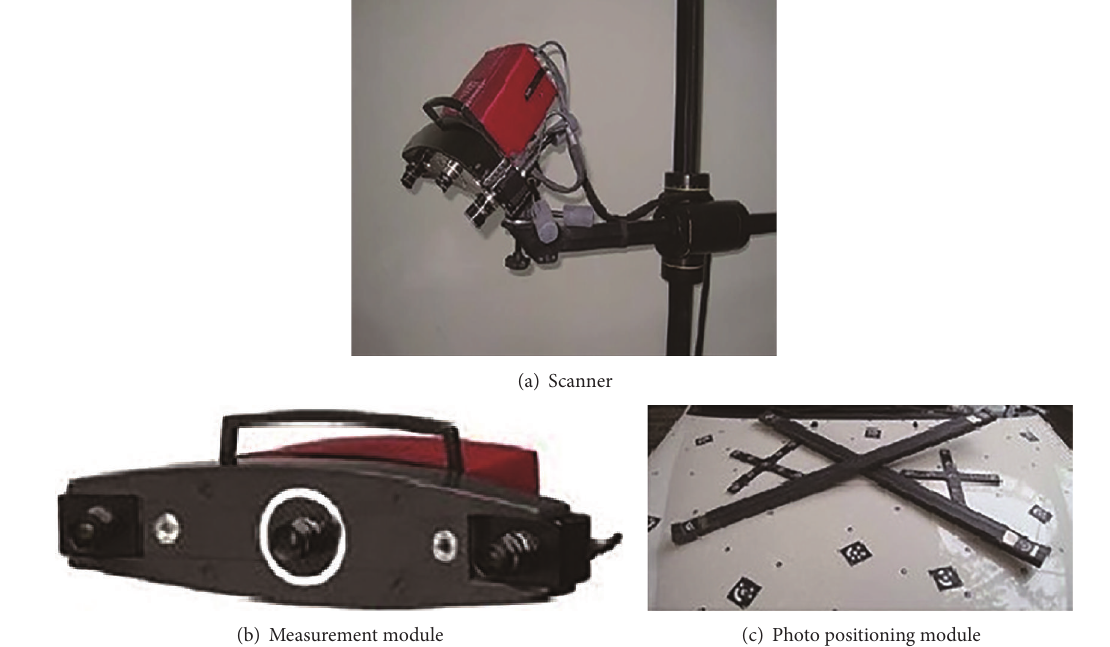
Figure 2: 3D optical scanner camera